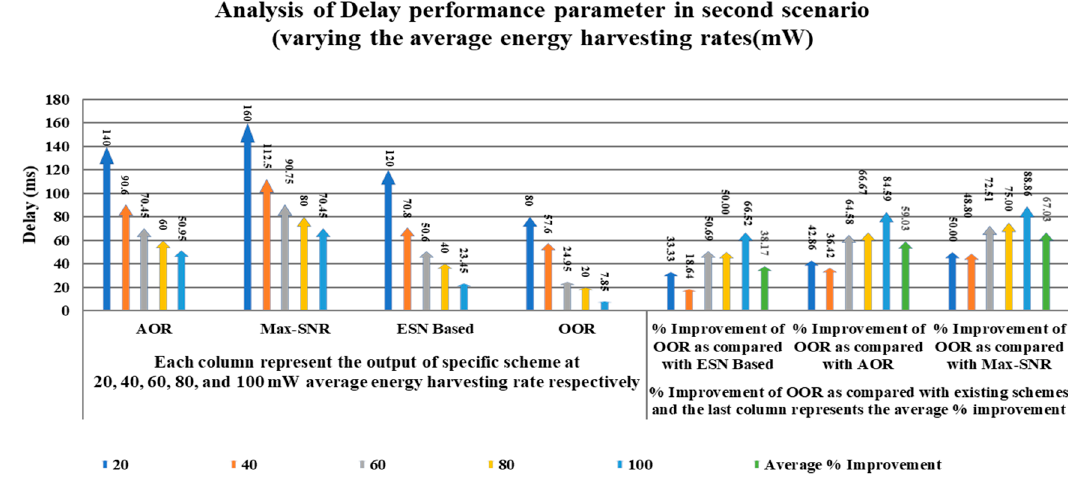
Figure 11. Detailed performance reflection of OOR with delay parameter (second scenario).